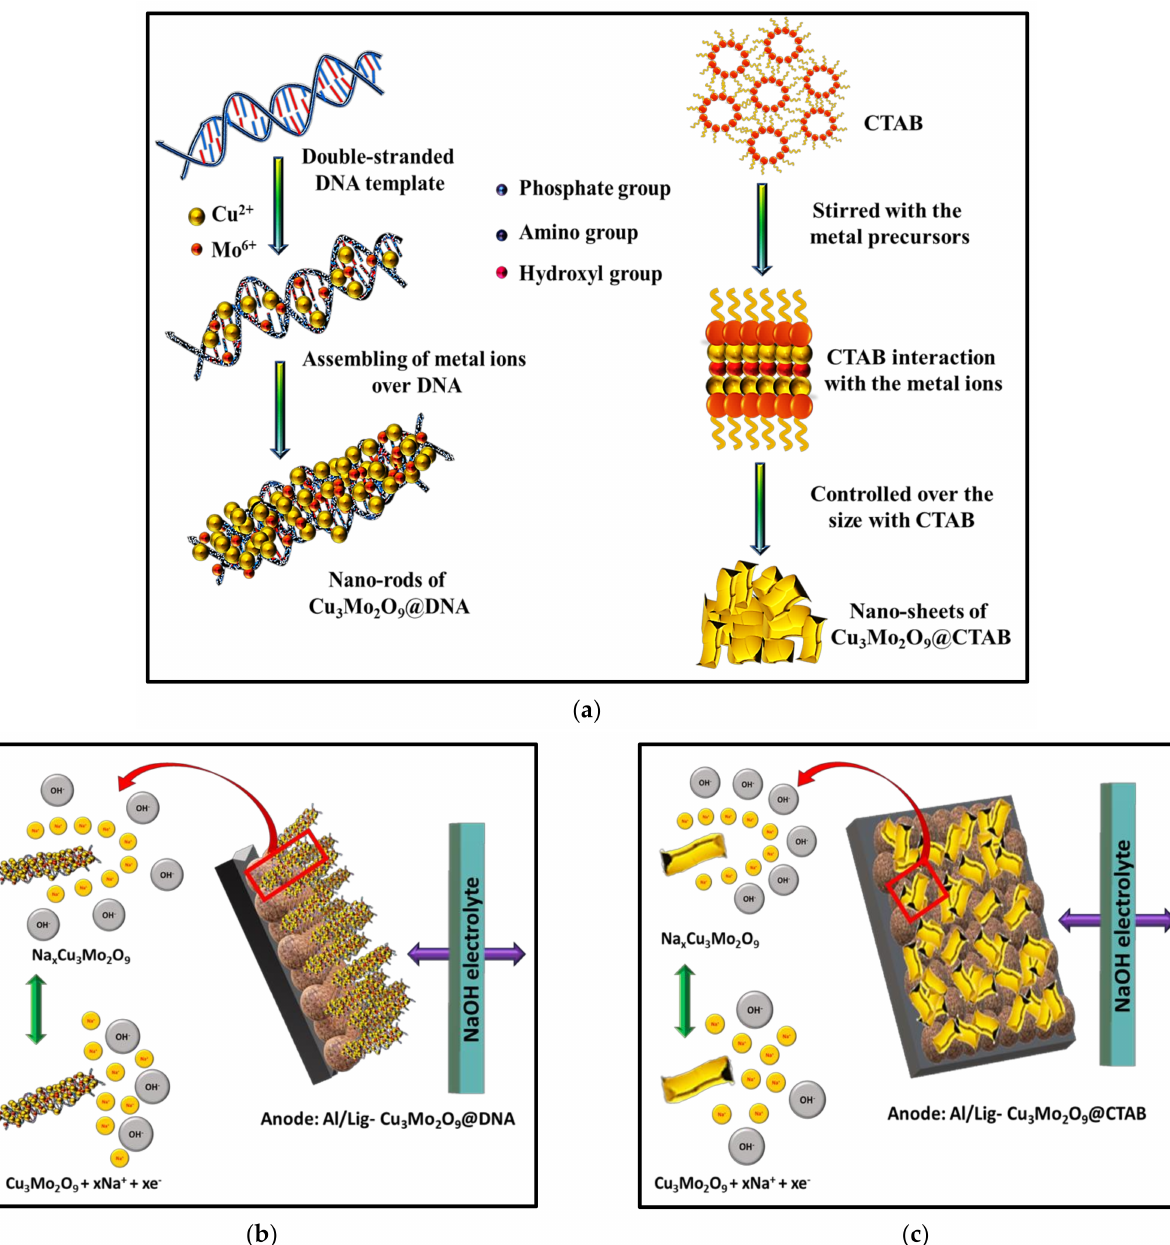
Figure 8. ( a ) Formation mechanism of Cu 3 Mo 2 O 9 using DNA and CTAB; storage mechanism during charging for ( b ) Cu 3 Mo 2 O 9 @DNA nanorods in the Al/Lig-Cu 3 Mo 2 O 9 @DNA supercapacitor; ( c ) Cu 3 Mo 2 O 9 @CTAB nanosheets in the Al/Lig-Cu 3 Mo 2 O 9 @CTAB